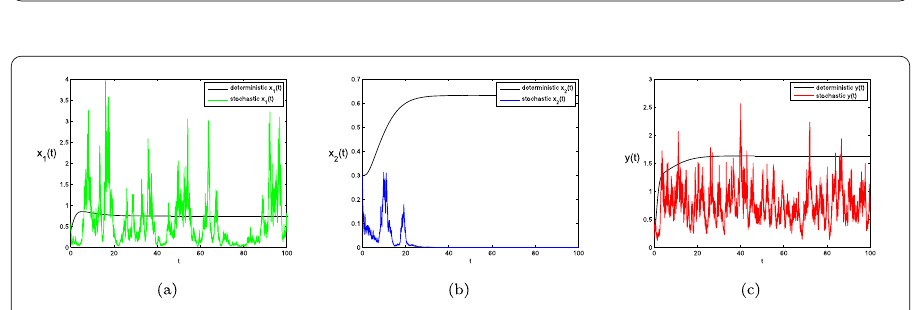
Figure 3 Solutions of stochastic system (3.1) with σ 1 = 0.95, σ 2 = 0.6, σ 3 = 0.7 show that x 2 goes to extinct but x 1 and y persists. ( a ) The solution of x 1 ( t ); ( b ) the solution of x 2 ( t ); ( c ) the solution of y ( t )